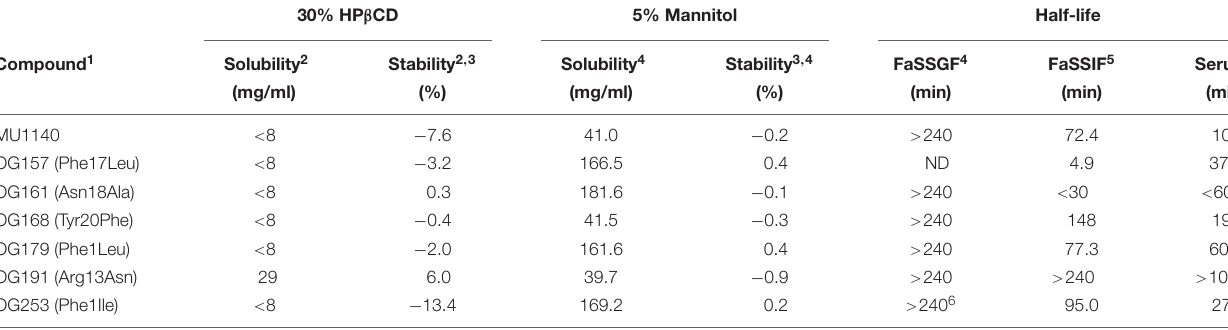
TABLE 3 | Metabolic and chemical stability, solubility and half life in biologically relevant